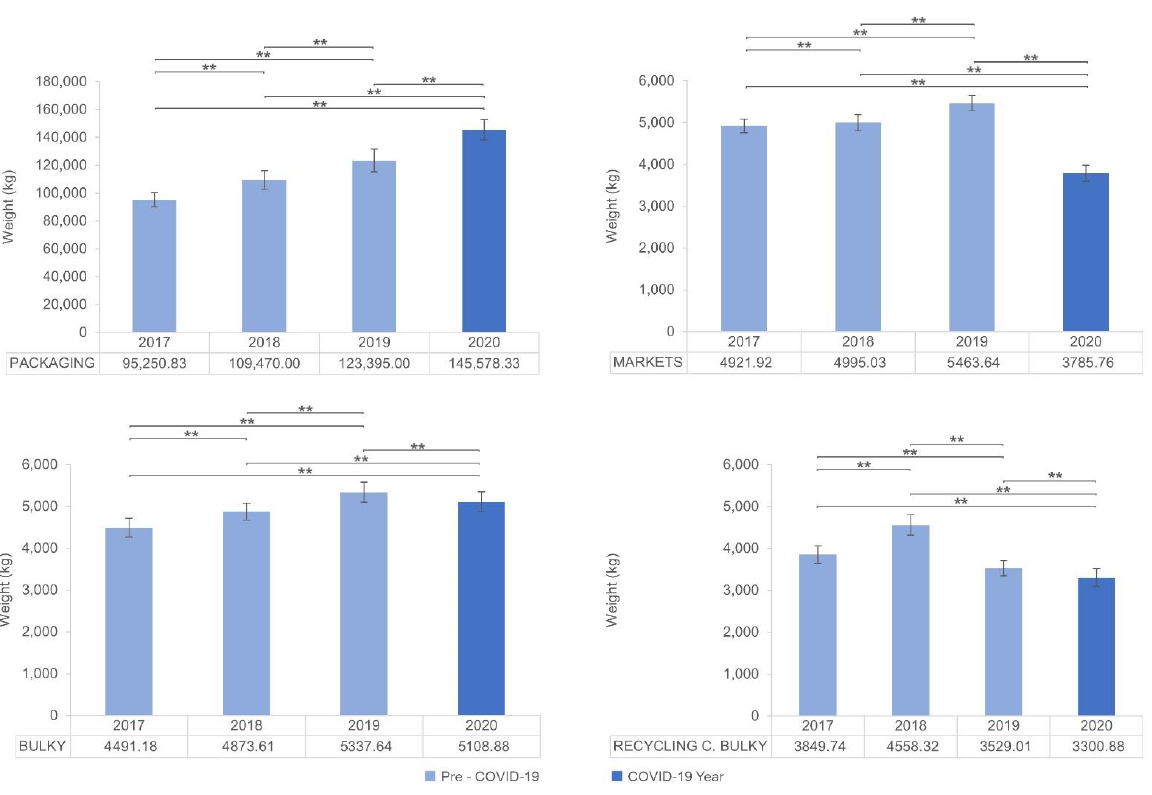
Figure 2. Mean and 95% CI for each year in waste fractions of Group 1: packaging, markets, bulky and recycling centre bulky waste collection. (**) for p < 0.01.